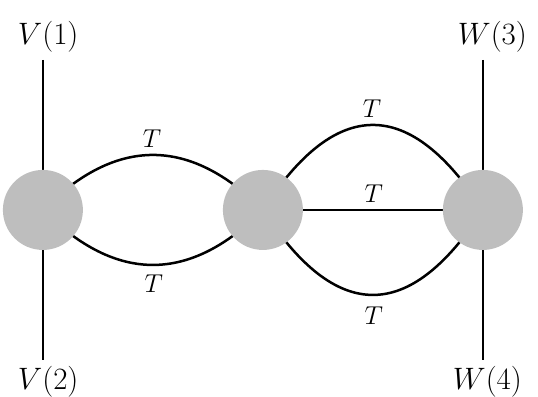
Figure 1. Feynman diagrams corresponding to stress tensor exchanges between two pairs of identical operators. The large grey circles refer to exact vertices h V V ˆ T . . . ˆ T i and h ˆ T . . . ˆ T i